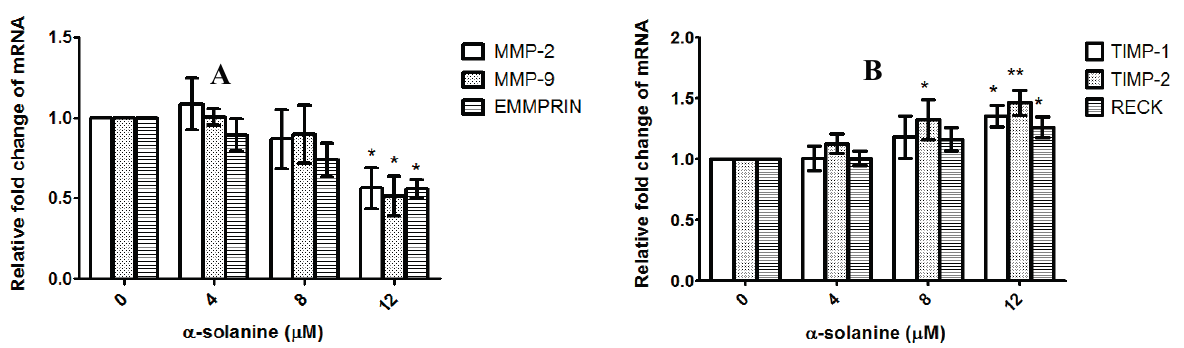
Figure 5. Effect of α -solanine on expressions of MMP-2/-9, EMMPRIN, RECK and TIMP-1/-2 in PC-3 cells. Cells were treated with various concentrations of α -solanine for 24 h and the expressions of MMP-2/-9 and EMMPRIN mRNA ( A ), and RECK and TIMP-1/-2 ( B ) were analyzed by quantitative real-time PCR. Data are expressed as mean ± S.D. of three independent experiments. * p < 0.05, ** p < 0.01 compared with the untreated